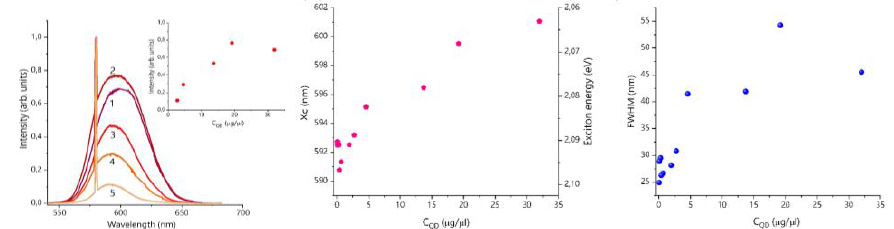
Fig. 1. Luminescence spectra of QD-solutions with intensity normalized to the laser excitation line (narrow line in the left part of the spectrum). The insert shows the concentration dependence of the luminescence spectrum intensity, measured at a maximum. The QD concentration in the samples: 1 - 32, 2 - 19.2, 3 - 13.7, 4 - 4.6, 5 - 2.7 μg/μl (on the left). The influence of the QD concentration in toluene on position X c (in center) and the FWHM (on the right) of the luminescence